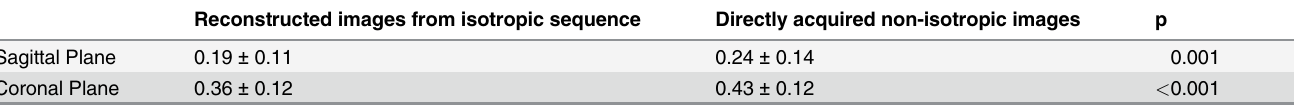
Table 5. Relative tumor contrast between tumor to gluteal muscle. Reconstructed images from isotropic sequence Directly acquired non-isotropic images